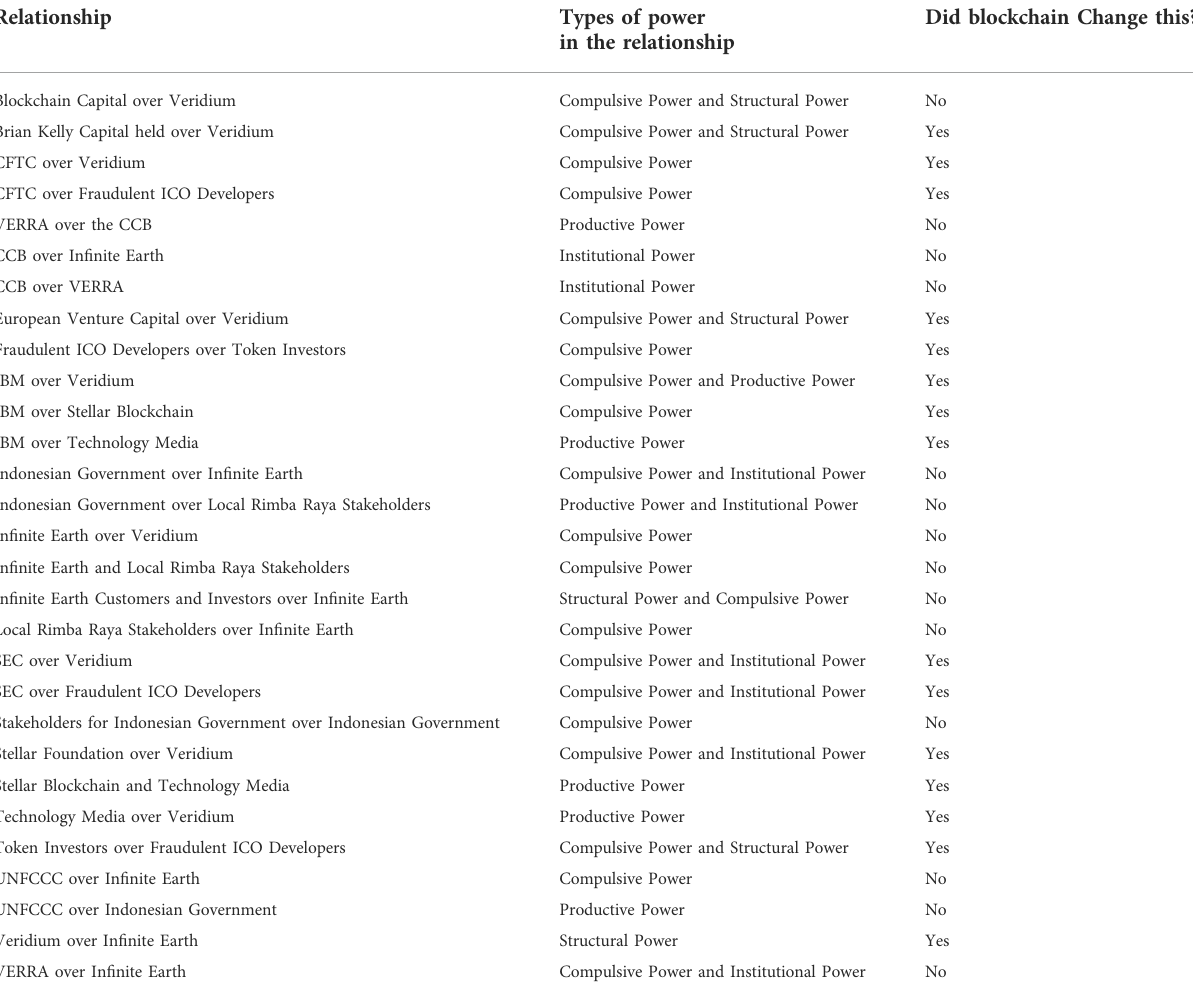
TABLE 3 List of Key Relationships, who held power over whom and the type of power present Note: some of the stakeholders mentioned in Table 4 are not included here because they were not identi fi ed as being an active part of the network at the time research was performed. Relationship